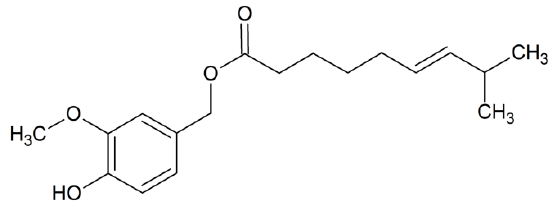
Figure 1. Chemical structure of capsiate (CTE).